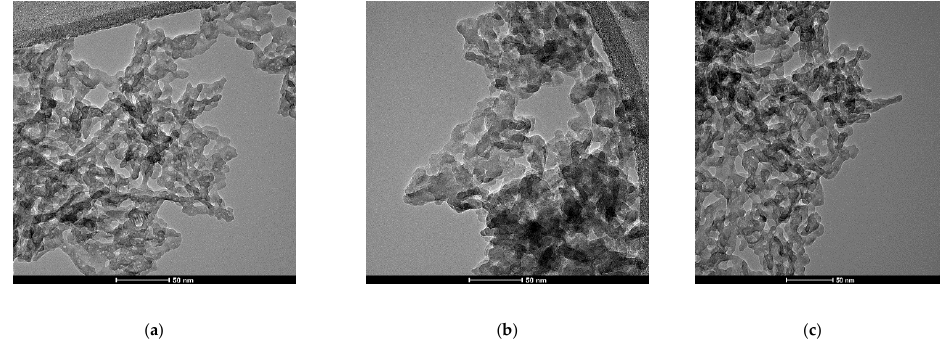
Figure 7. TEM images, for x = 0.05 ( a ) , x = 0.25 ( b ), x = 1 ( c ).